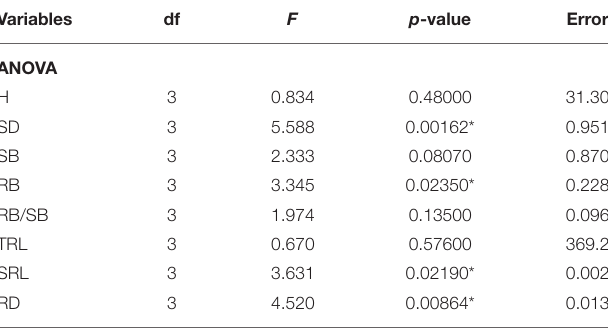
TABLE 4 | Analysis of variance (ANOVA) for treatments of seedling growth parameters of Tectona grandis at 90 days after mini-cuttings planting.